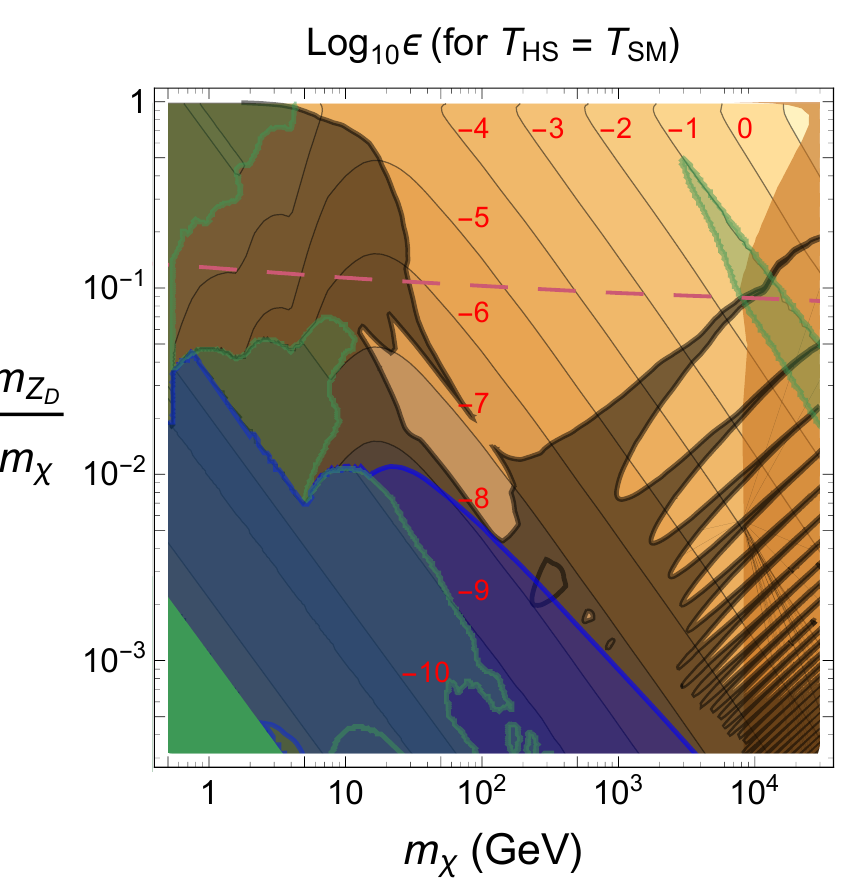
Figure 7 . Combined constraints on the kinetic mixing coupling (cid:15) in the vector model. The black region shows the combined indirect detection constraints (see (cid:12)gure 4) and excludes all values of (cid:15) for the indicated masses given T SM = T HS at the time of freezeout. Regions where direct detec- tion constraints are superseded by constraints on the mediator (collider, beam dump, supernova, etc.) are shown in green. Labelled contours show the maximum value of (cid:15) permitted by either direct detection or mediator constraints, whichever bound is stronger. The blue region indicates where thermalization cannot occur prior to DM freezeout, the brown contour illustrates where the freezeout calculation is less reliable, and above the pink dashed line the mediator is non-relativistic during freezeout. The solid green region in the lower left is where m Z < 2 m e D